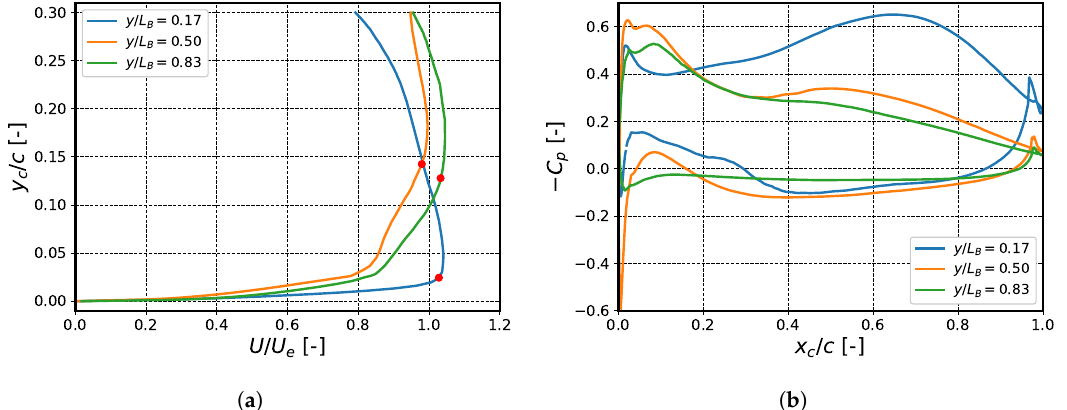
Figure 5. Three isoradial cuts are plotted at 3 spanwise locations y / L B : ( a ) the boundary-layer velocity profiles are depicted as functions of the non-dimensional boundary-layer distance y c / c with the red dots corresponding to the boundary layer thickness δ ; ( b ) the negative pressure coefficient C p is plotted as function of the chordwise nondimensional coordinate x c / c